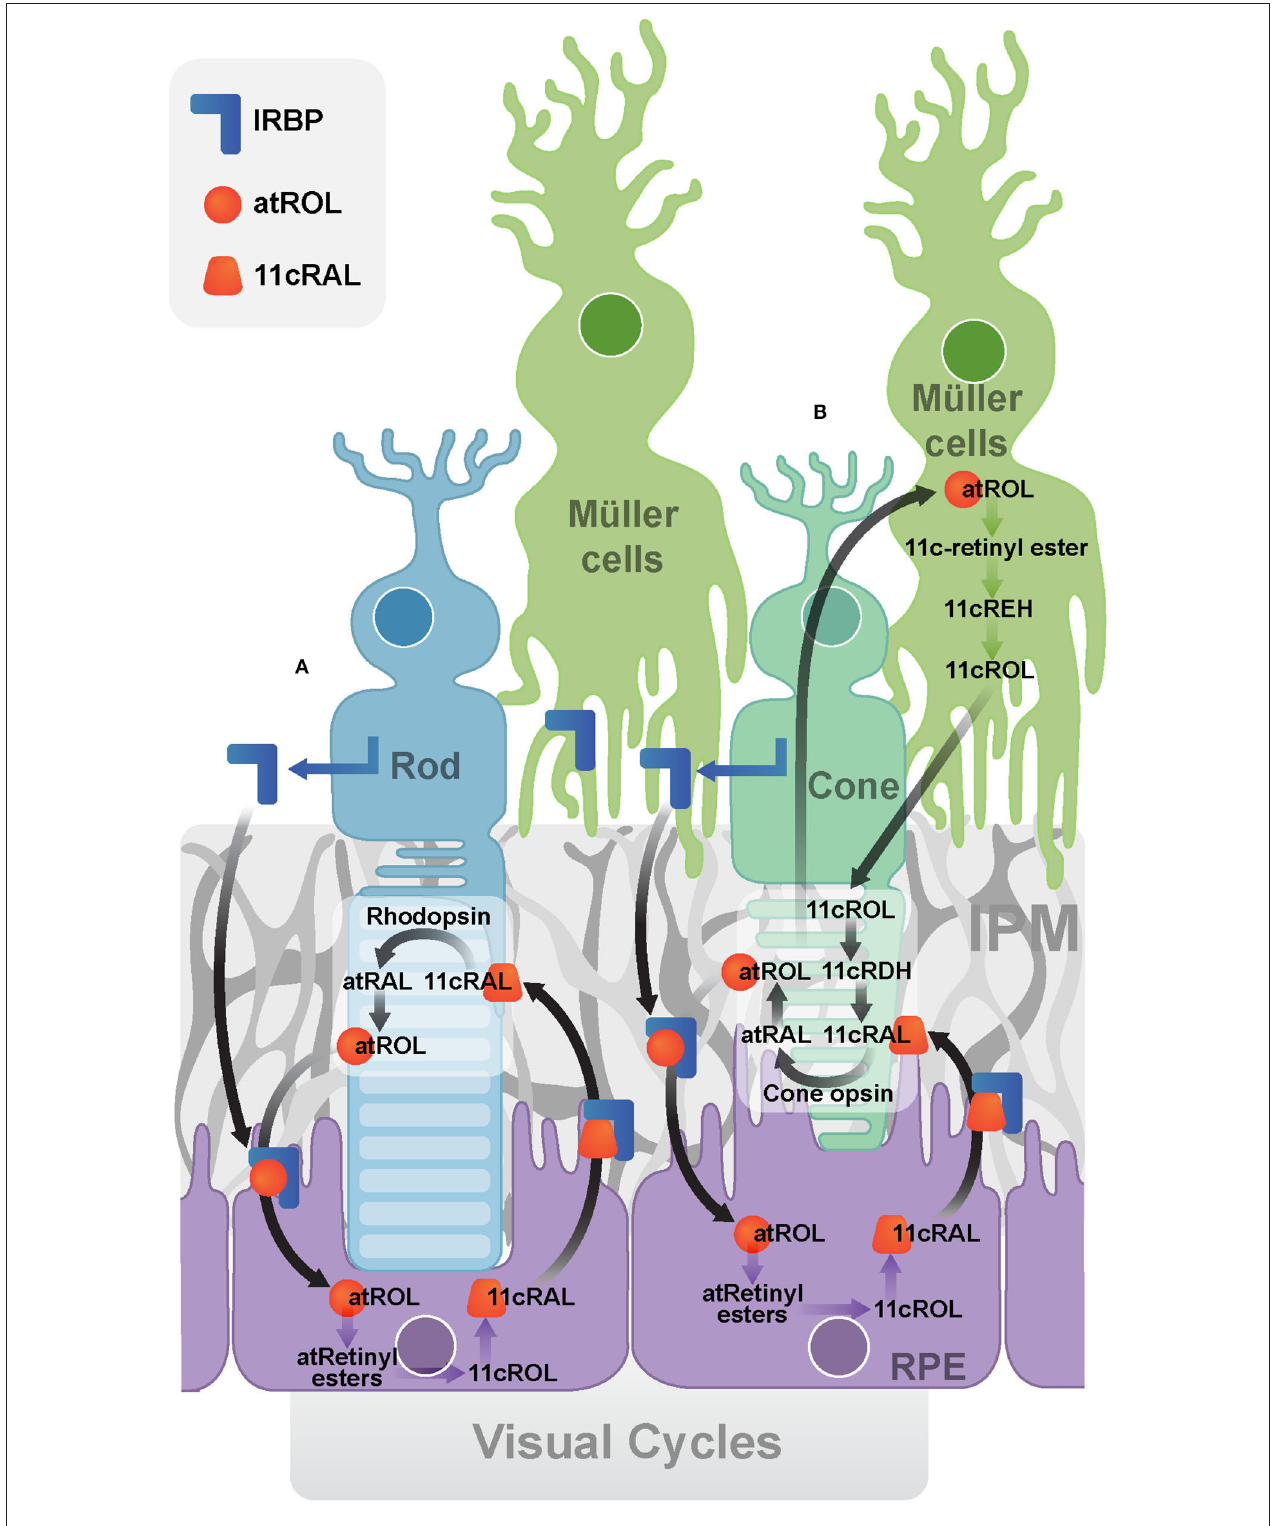
FIGURE 2 | Visual Cycles. (A) The canonical visual cycle. IRBP facilitates the transport of retinoids (atROL and 11cRAL) between photoreceptors and the RPE. (B) The cone-specific visual cycle between cone photoreceptors and Müller cells. (IRBP, Interphotoreceptor retinoid-binding protein; IPM, interphotoreceptor matrix; RPE, retinal pigment epithelium; atRAL, all- trans -retinal; atROL, all- trans -retinol; 11cRAL, 11- cis -retinal; 11cROL, 11- cis -retinol; 11cRDH, 11- cis -retinol dehydrogenase; 11cREH, 11- cis -Retinyl ester hydrolase).